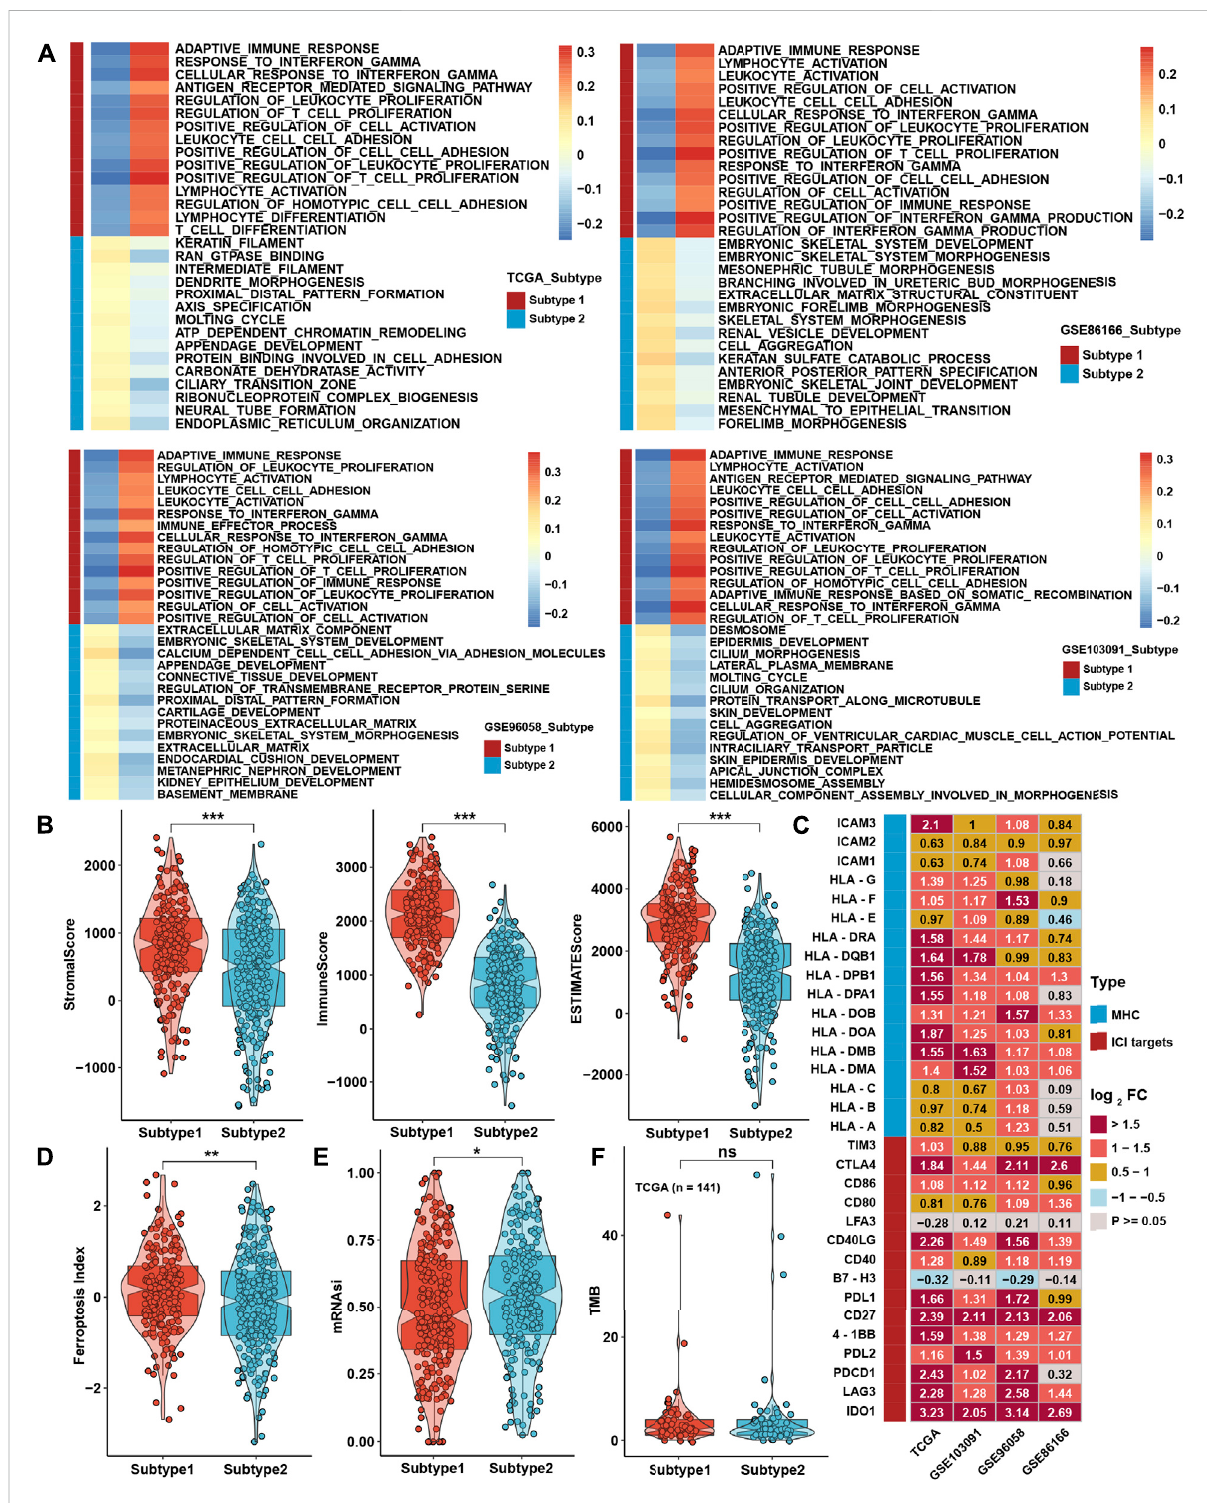
FIGURE 4 Biological function analysis between TME subtypes. (A) GSEA between two TME subtypes in four TNBC cohorts. (B) Differences in ESTIMATE analysis results between TME subtypes in the whole TNBC cohort. (C) Differential expression analysis of MHC molecules and immune checkpoint inhibitorsbetweenTMEsubtypesinfourTNBCcohorts. (D,E) DifferencesintheresultsforFPIandmRNAsibetweenTMEsubtypesinthewholeTNBC cohort. (F) Differences in TMB between TME subtypes in the TCGA cohort. The asterisks represent the statistical p value (* p < 0.05; ** p < 0.01; *** p <